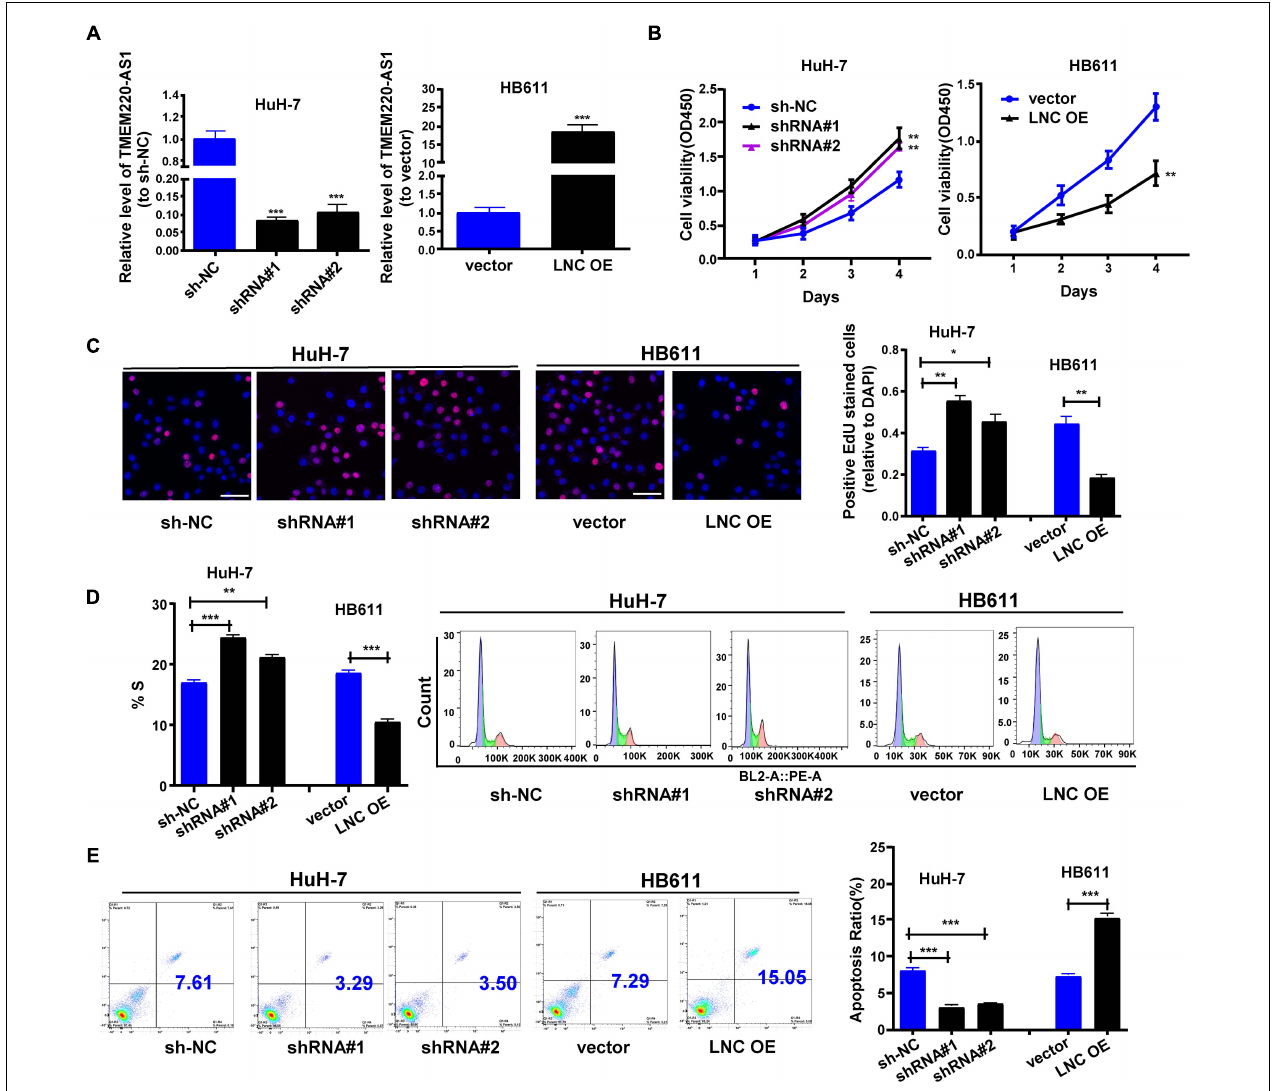
FIGURE 2 | TMEM220-AS1 inhibits the proliferation and cell cycle of HCC cells, but promotes the cell apoptosis of HCC cells. (A) Transfection efficiency of sh-TMEM220-AS1#1 (shRNA#1), sh-TMEM220-AS1#2 (shRNA#2) and TMEM220-AS1-overexpressing vector (LNC OE). (B) Cell viability was analyzed by (B) CCK-8 assay and (C) EdU assay (bar = 50 µ m). (D) Cell cycle. (E) Cell apoptosis. Data were presented as represent the mean ± SD of 3 independent experiments; * P < 0.05, ** P < 0.01, *** P < 0.001.